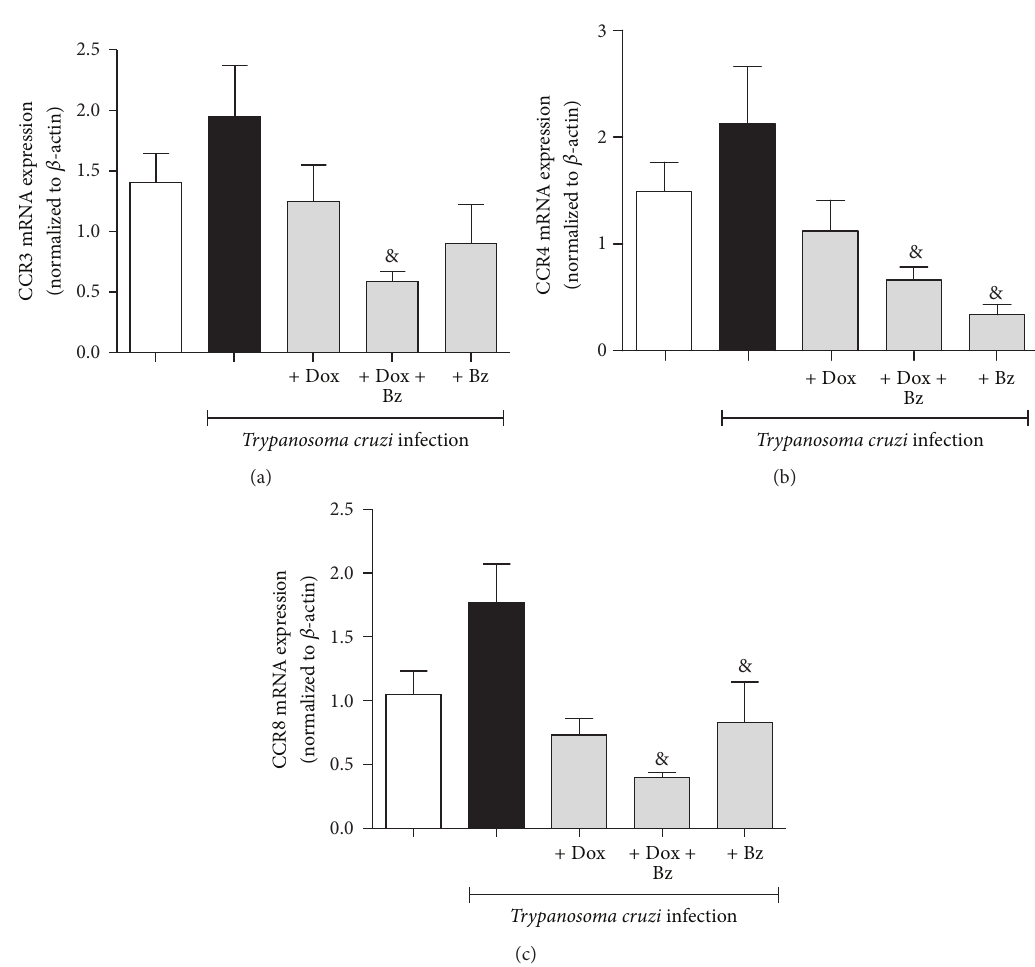
Figure 5: Expression of Th2/Th17-like chemokine receptors in the cardiac tissue from dogs infected with the Trypanosoma cruzi . Th2/TH17- like chemokine receptors (CCR3, CCR4, and CCR8) mRNA expression evaluated in the left ventricle tissues. Data are representative of the groups ( 𝑛 = 5 animals) in which the expression of chemokine receptors was normalized to the constitutive beta-actin. & means difference ( 𝑝 < 0.05 ) in relation to the infected group without